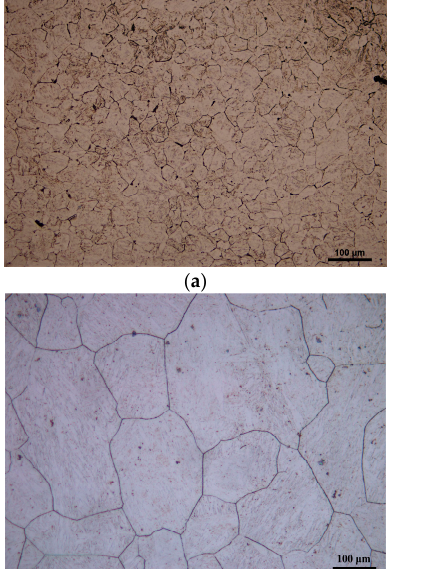
Figure 3. Microstructure of 20Mn5 steel compressed to a true strain of 0.7 under strain rate of 0.01/s and temperatures of: ( a ) 850 °C; ( b ) 900 °C; ( c ) 950 °C; ( d ) 1000 °C; ( e ) 1050 °C; ( f ) 1100 °C; ( g ) 1150 °C; ( h ) 1200 °C.